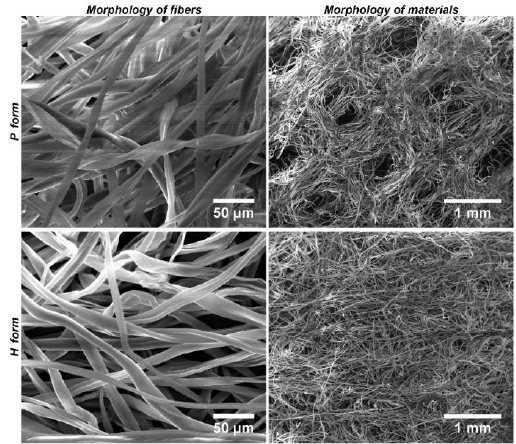
Figure 1. Morphology of the P form and the H form of Hcel ® NaT. Quanta 450 scanning electron microscope, original magnification 1000×, scale bar 50 µm; 70×, scale bar 1 mm.